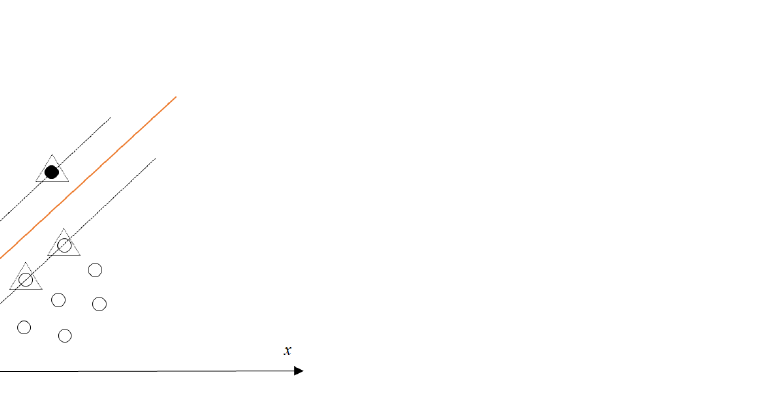
Figure 5. Optimal hyperplane for binary classification. The yellow line in the middle is the classification hyperplane. The points on the two black dotted lines are the points closest to the hyperplane, and these points are support vectors.